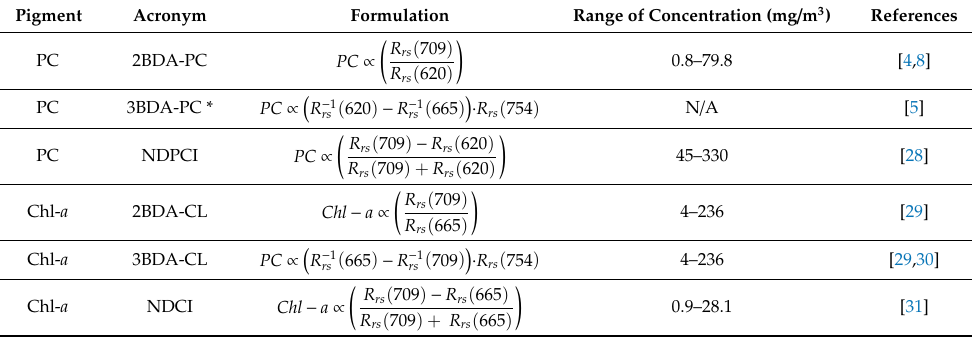
Table 1. Semi-empirical algorithms for the remote estimation of phycocyanin